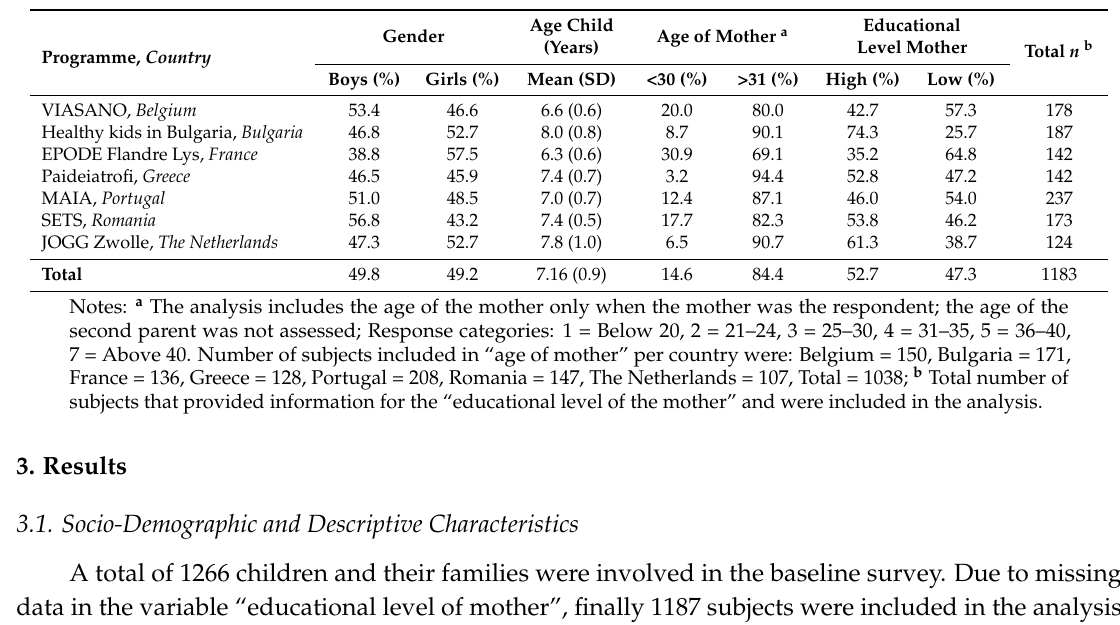
Table 1. Socio-demographic characteristics of the EPHE